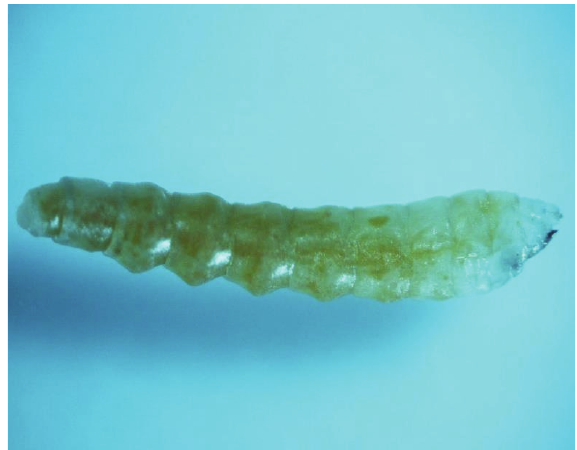
Figure 10: The spatulate third instar larva. Note that the head capsule is comparatively minute.